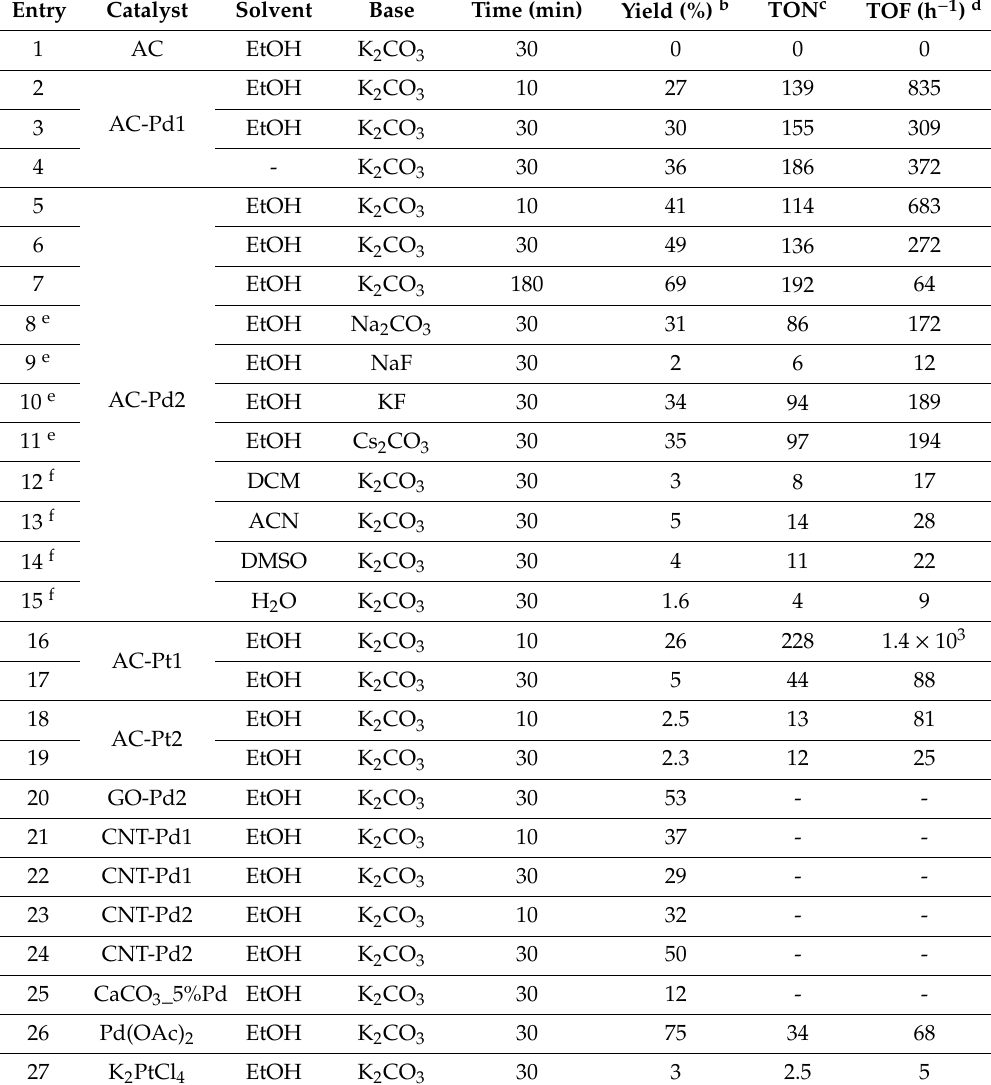
Mechanochemical Suzuki—Miyaura cross-coupling reactions of bromobenzene with phenylboronic acid a